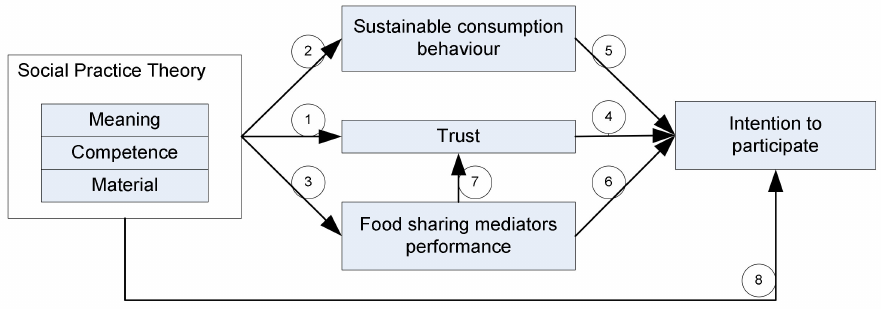
Figure 7. A conceptual framework for food sharing as collaborative